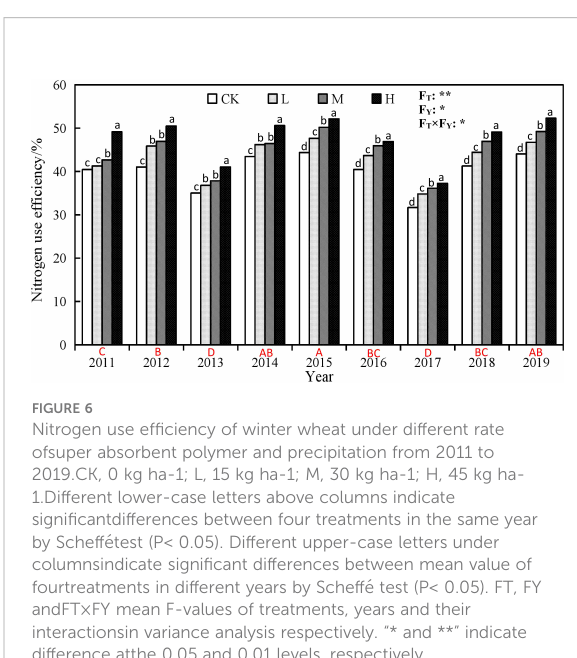
TABLE 5 Relationships among photosynthetic rate, transpiration rate, leaf water utilization ef fi ciency, yield, water and nitrogen use ef fi ciency. Index Pn Tr LWUE Yield